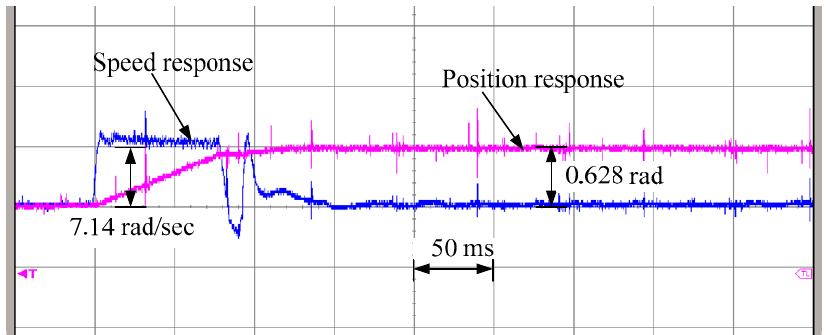
Figure 17. The experimental responses of position and speed response with step command input.